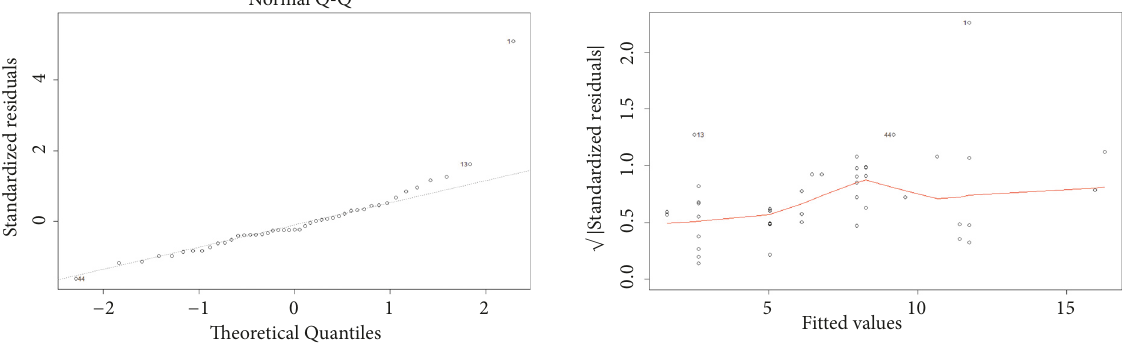
Figure 1: Residual Plots.